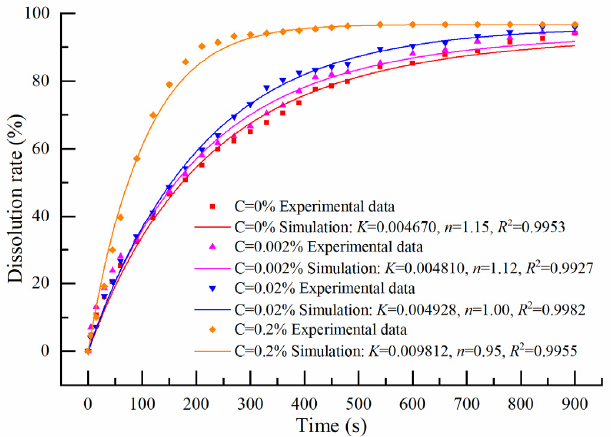
Figure 10. Effects of surfactant addition on chloride ion dissolution rate with S/L ratio of 1:50 and stirring speed of 600 rpm at 25 ◦